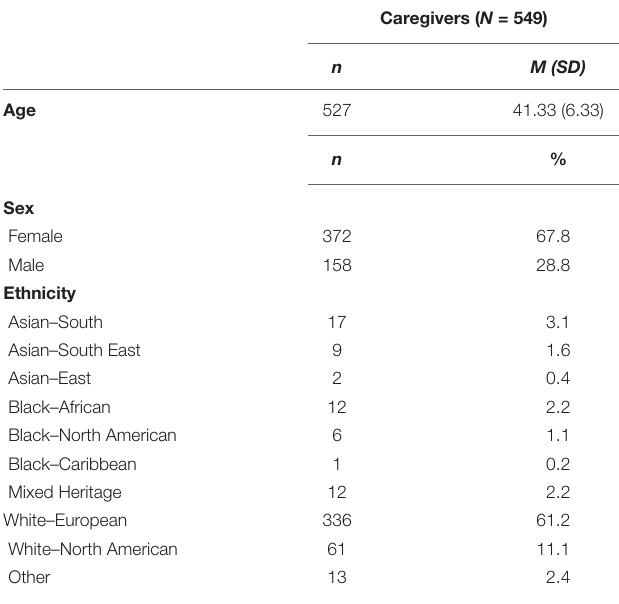
TABLE 1 | Descriptive statistics for study